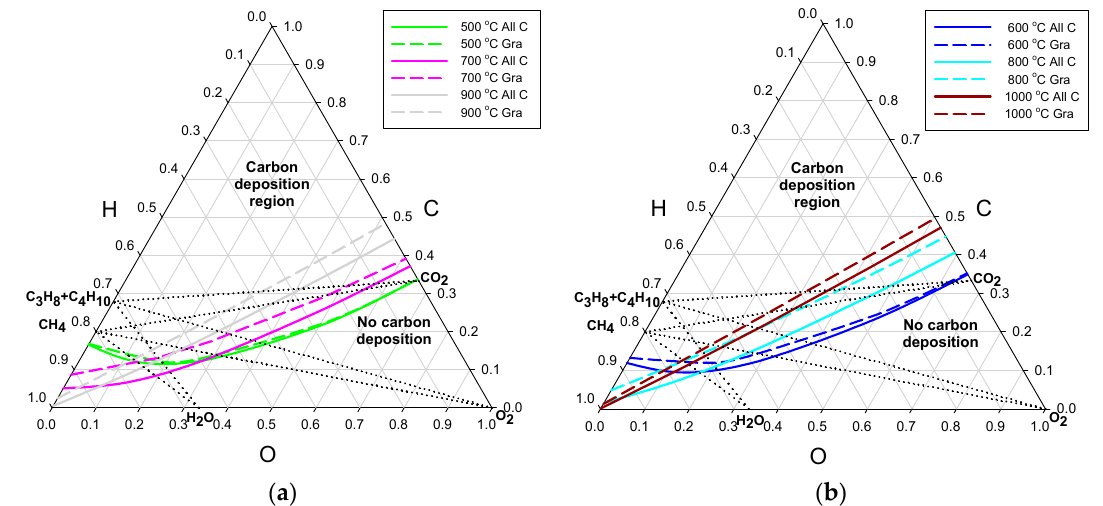
Figure 2. Deposition threshold lines for the process pressure of 3 bar, separately for graphite only—broken lines, and all carbon allotropes—solid lines: ( a ) temperatures of 500, 700, and 900 °C; and ( b ) temperatures of 600, 800, and 1000 °C.